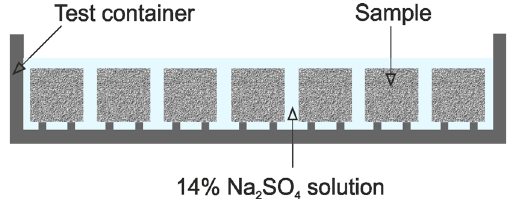
Fig. 1 Experimental set-up of UHPC resistance to sodium sulphate crystallization